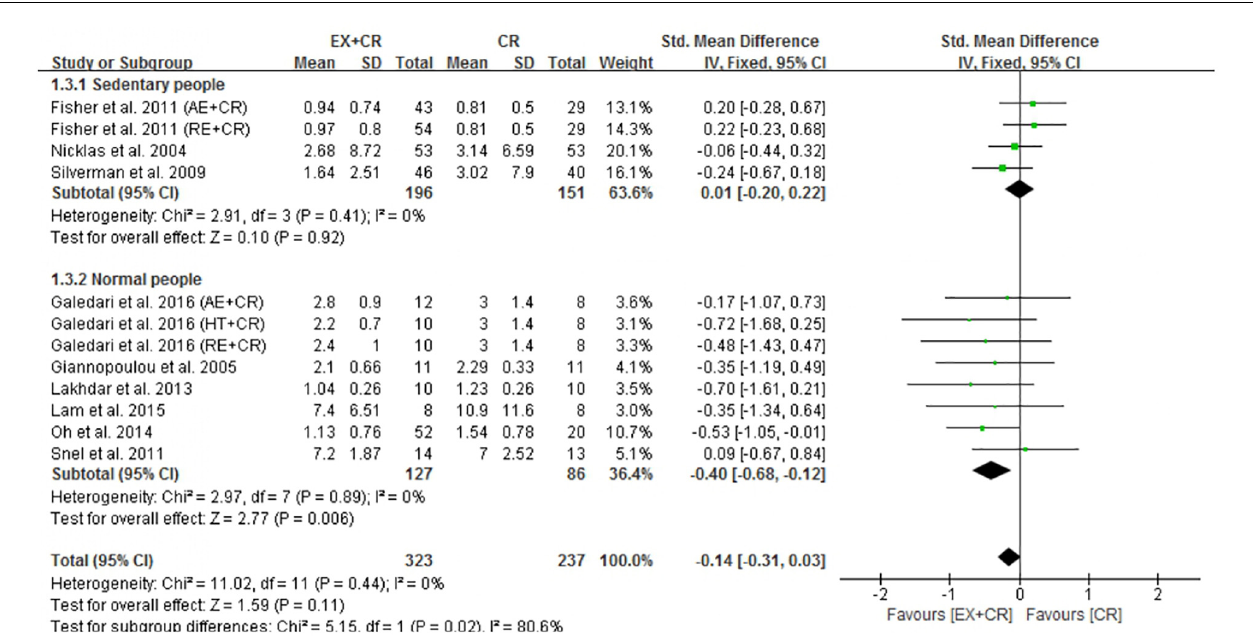
FIGURE 4 | Forest plot of the effects of exercise plus calorie restriction (EX + CR) intervention on TNF- α changes in overweight and obese adults with different (subgroup analysis) lifestyle behaviors.